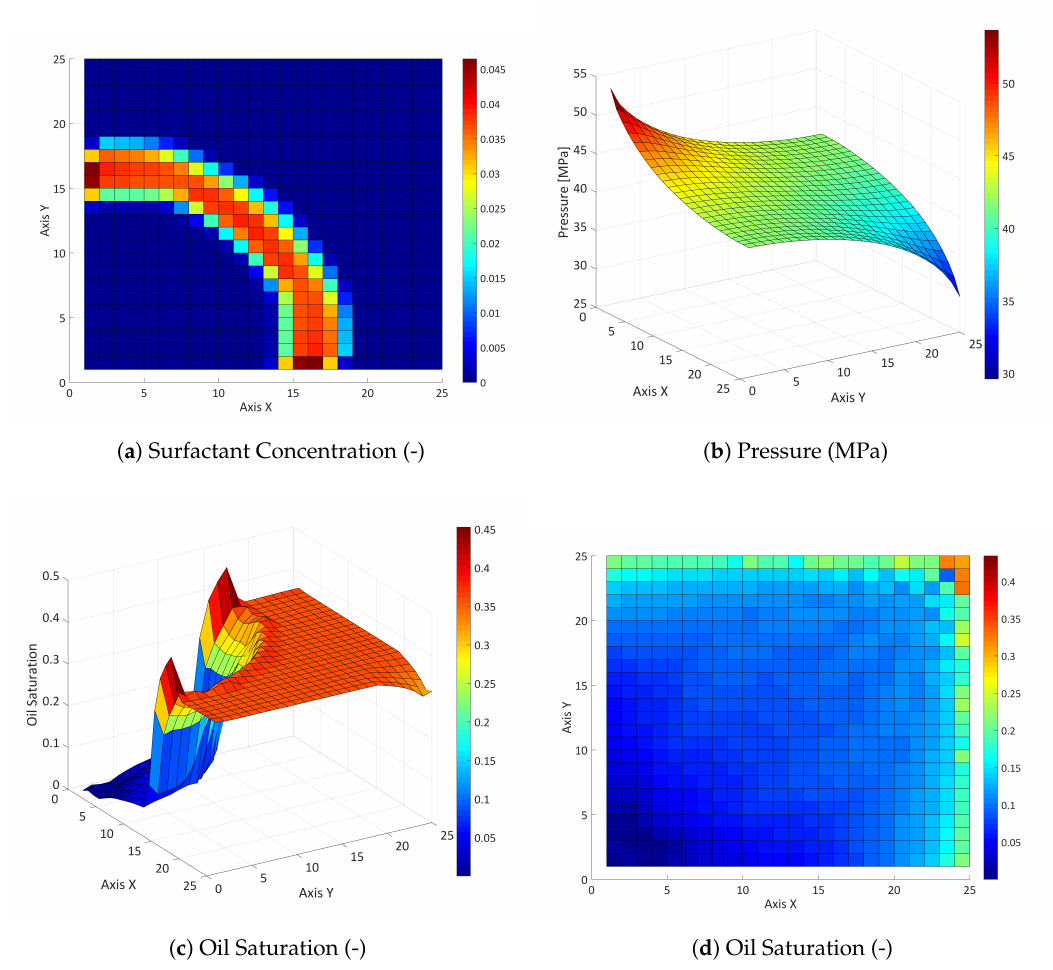
Figure 9. Chemical ( a ) and pressure profiles ( b ) after 3000 days of simulation. Oil saturation profiles at 3000 days ( c ) and at the end of the EOR process ( d ) for a Type II(+) emulsion with k c =